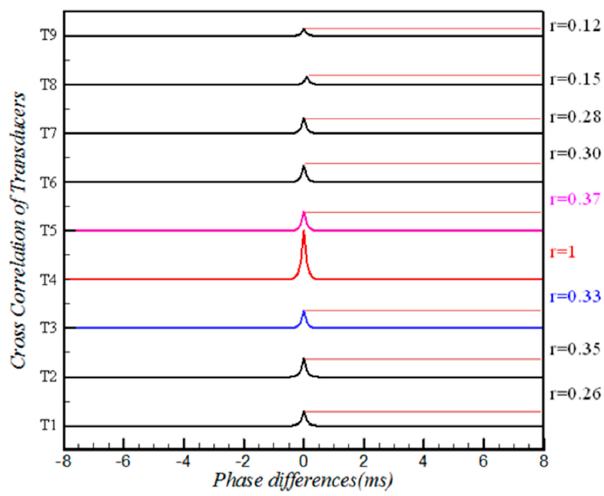
Figure 14. Phase analysis of T1–T9 ( t = 3 s). Aerospace 2019 , 6 , x FOR PEER REVIEW